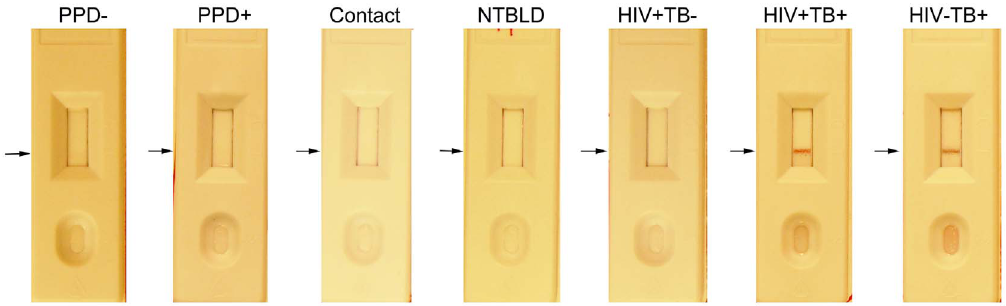
Figure 1. Visual example of reactivity of BSA-peptide P6 with sera on lateral flow. Reactivity with one serum specimen from each of the groups of non-TB controls and TB patients included in the study with BSA-peptide conjugate P6 is shown. In general the serum specimens from non- TB subjects exhibited no detectable reactivity with the striped BSA-peptide conjugate while sera from smear positive TB patients produced test lines easily distinguished by the